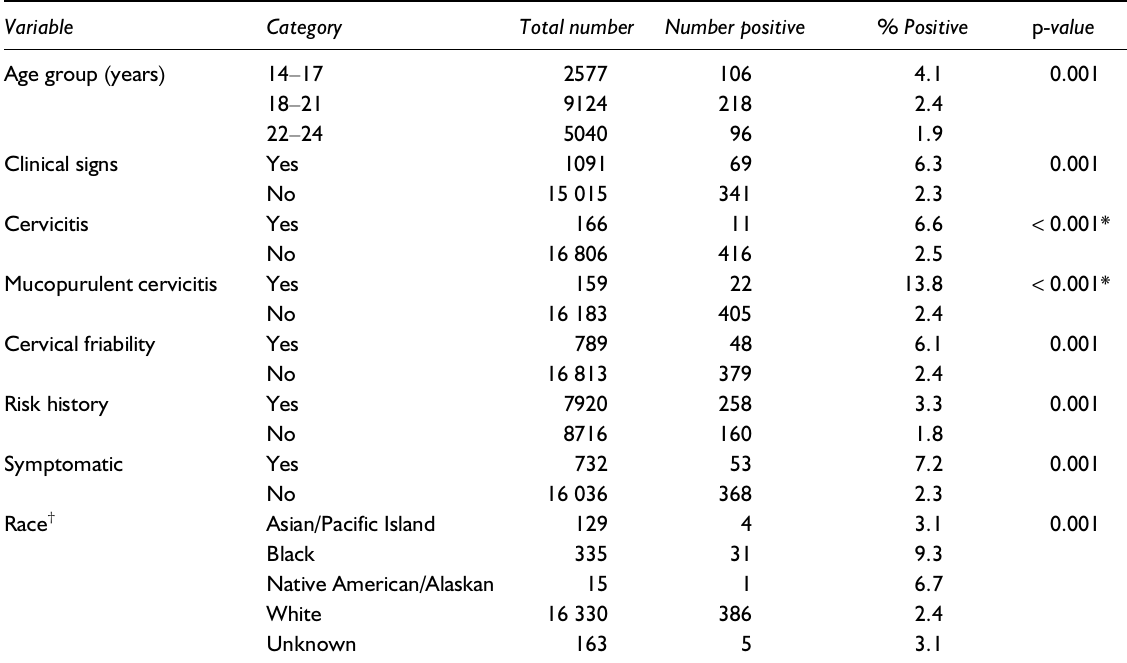
Table 1 Characteristics of women 24 years of age and younger attending family planning clinics throughout the State of Iowa ( n = 16